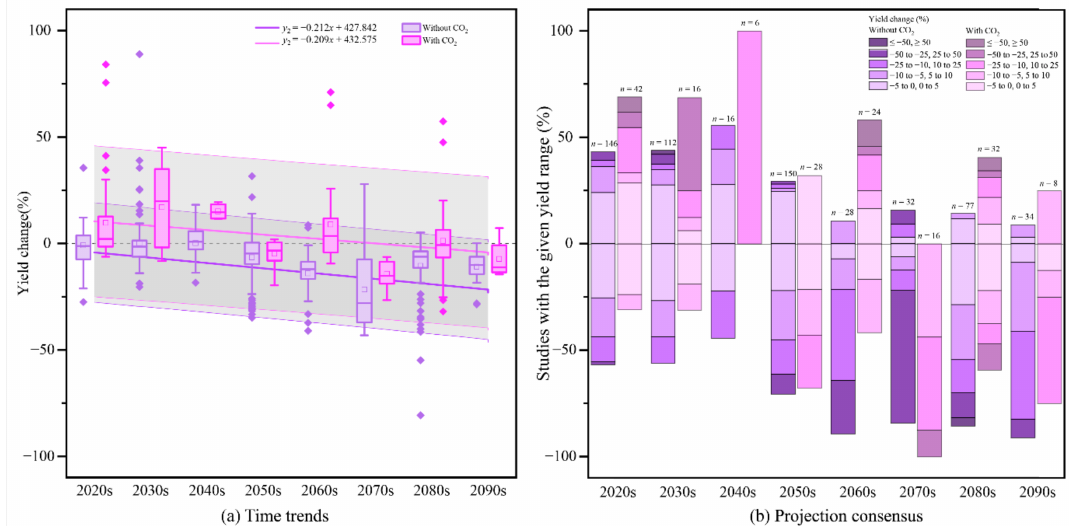
Figure 3. Temporal trend and results of the consensus of crop yield changes in China under climate change. (( a ) Box plot showing the temporal trend of the yield change results; the middle of the box plot represents the median; the square represents the mean; the colors indicate the results of whether CO 2 factors are considered (pink is with, and purple is without). The shaded portion of the trend line in the figure indicates the uncertainty interval, which is ± 23% without CO 2 and ± 35% with CO 2 . ( b ) Bar graph showing the range of consensus levels for the results of crop yield changes, with the n value indicating the number of results for the estimated crop yield for that